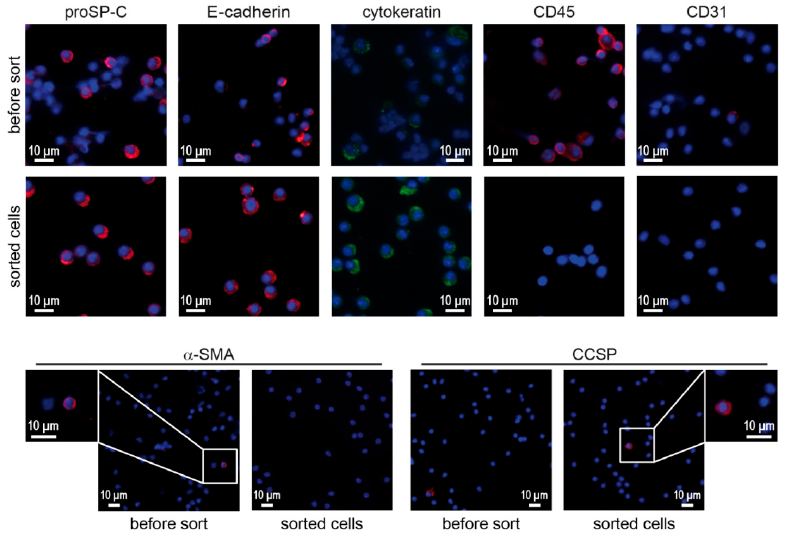
Figure 2. Immunofluorescence for phenotypic markers on cytocentrifuge preparations of lung cell suspensions (before sorting) and sorted cells. Cytocentrifuge preparations of whole lung cell suspensions and sorted cells were stained for phenotypic markers associated with ATII cells (proSP-C, E-cadherin, cytokeratin), leukocytes (CD45), endothelial cells (CD31), smooth muscle cells ( α -SMA) and Club cells (CCSP). Scale bars represent 10 µm.